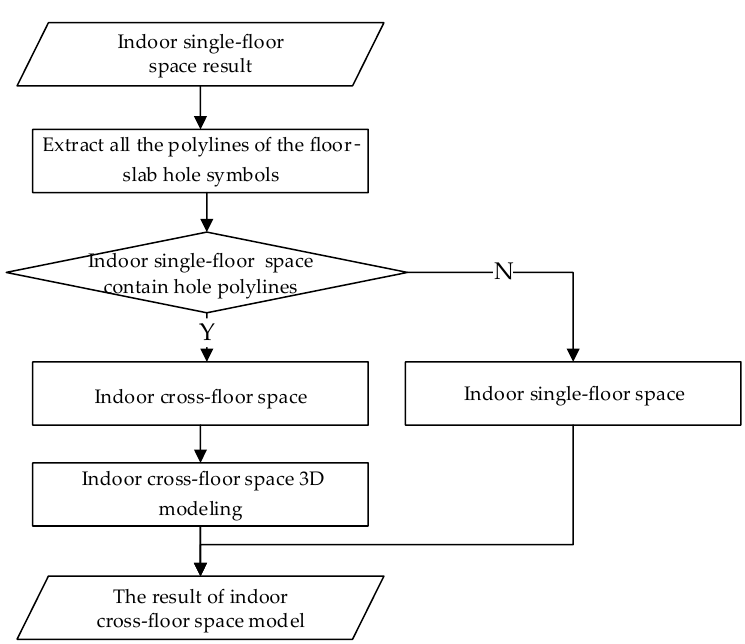
Figure 13. Flowchart for extracting a cross-floor space.